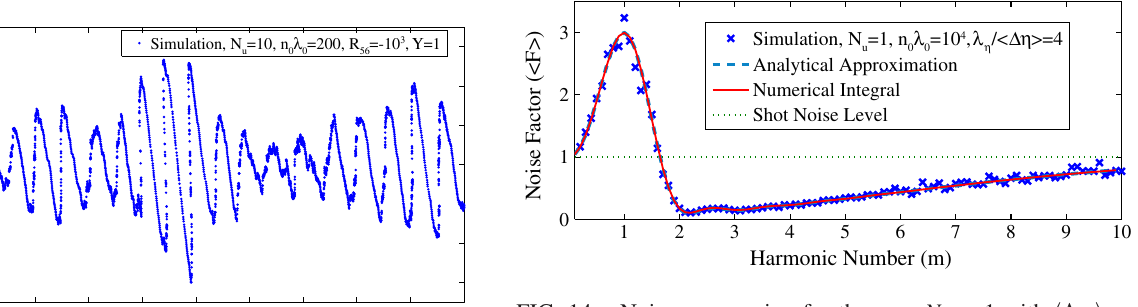
FIG. 14. Noise suppression for the case N u ¼ 1 with h (cid:5) (cid:1) i (cid:6) = 5 . For the parameters given, (cid:10) = 8 . With higher (cid:2) (cid:6) (cid:10) (cid:1) min 0 charge density n , suppression extends to shorter 0